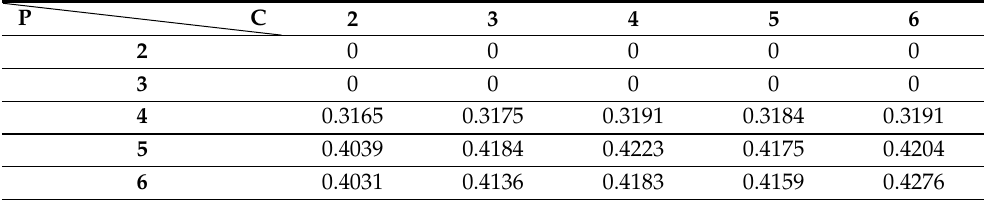
Table 1. Performance index of GM that created context evenly.